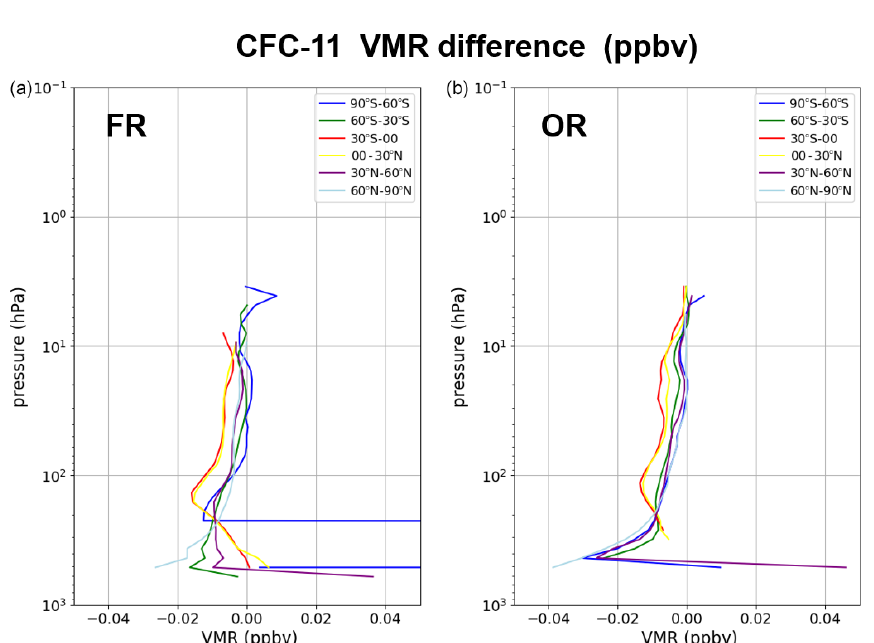
Figure 12. Same as Fig. 10, but for the HCFC-22 profiles.